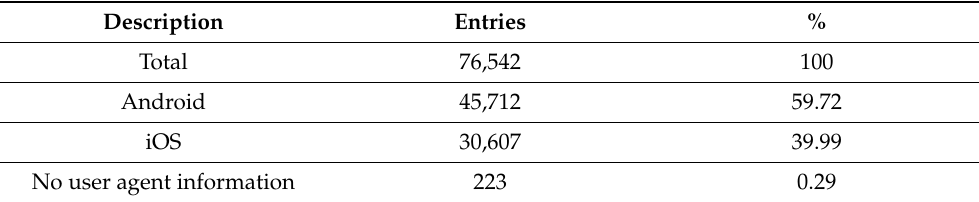
Table 1. Data set from the TYT database used for the